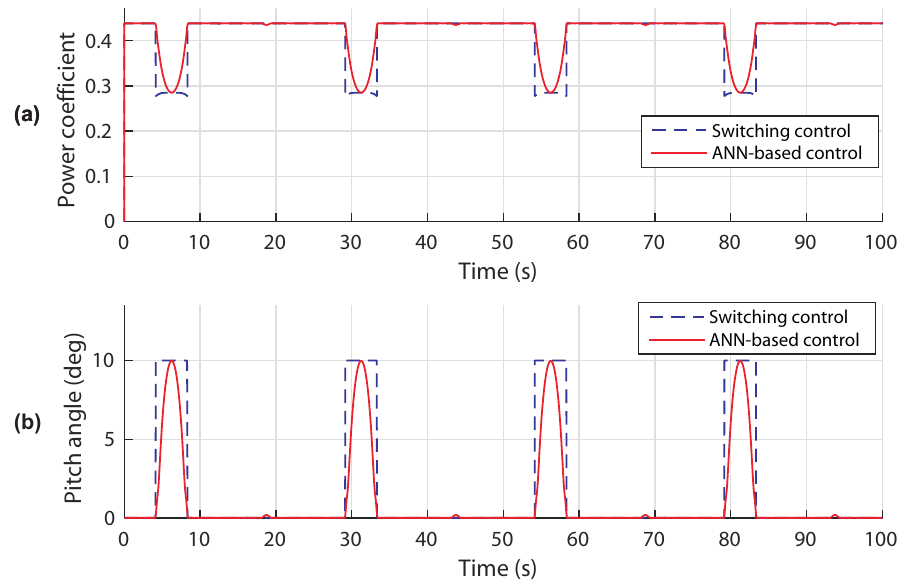
Figure 14. Control performances in scenario 1: ( a ) power coefficient response; ( b ) pitch angle